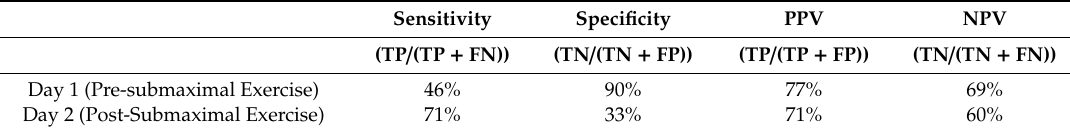
Table 6. Matrix of total reported subject results and general reported statistics for actual totals of subjects captured by model prediction on test set. Sensitivity and specificity are reported for the most accurate performing non-cross validated model (70.6% on Day 1 and 85.3% on Day